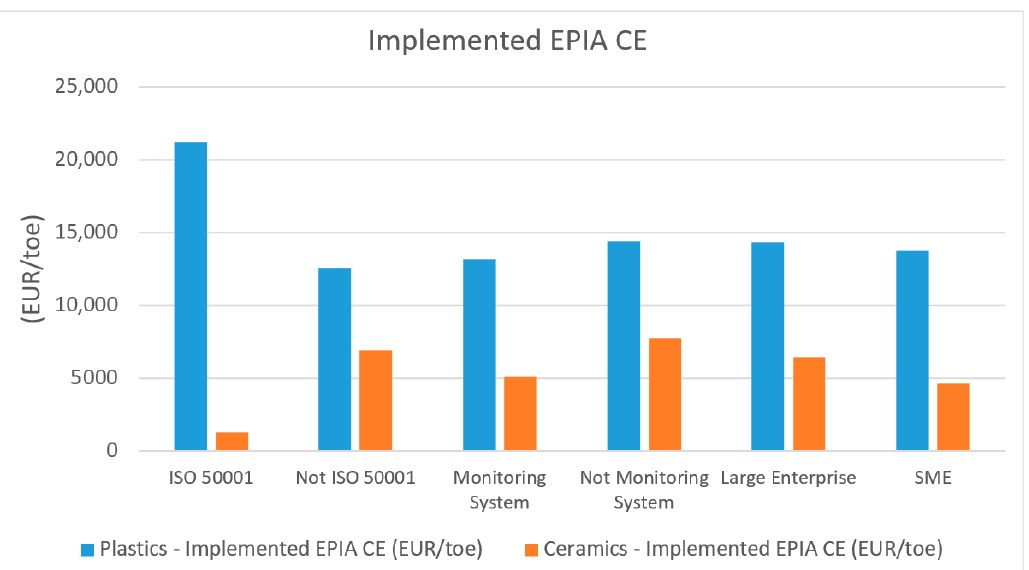
Figure 6. Implemented EPIA cost effectiveness (plastics and ceramics).